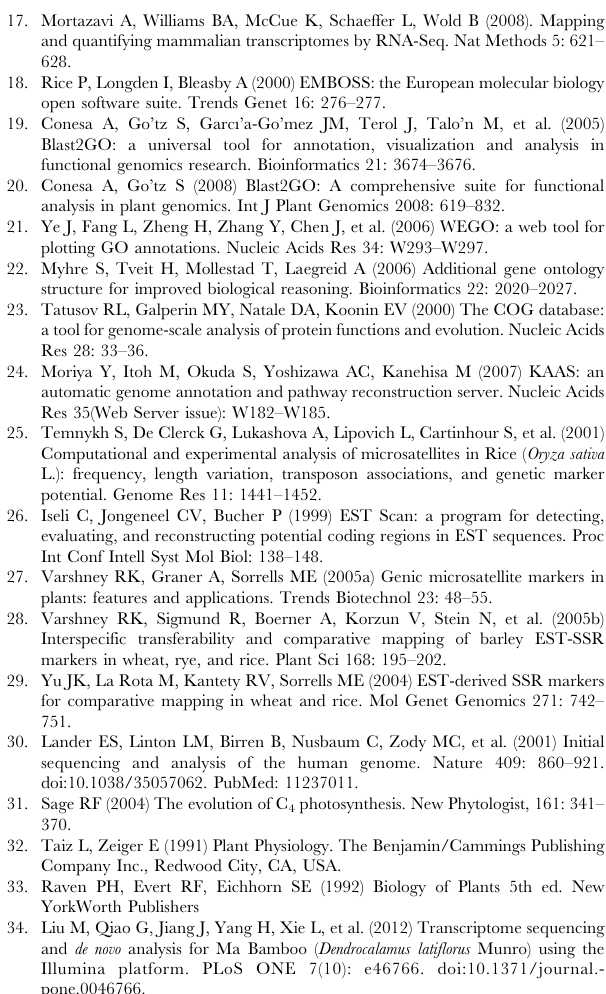
Table S1 Unigenes related to plant-pathogen interac- tion pathway. Table S2 Unigenes related to secondary metabolites biosynthesis, transport and catabolism pathway.